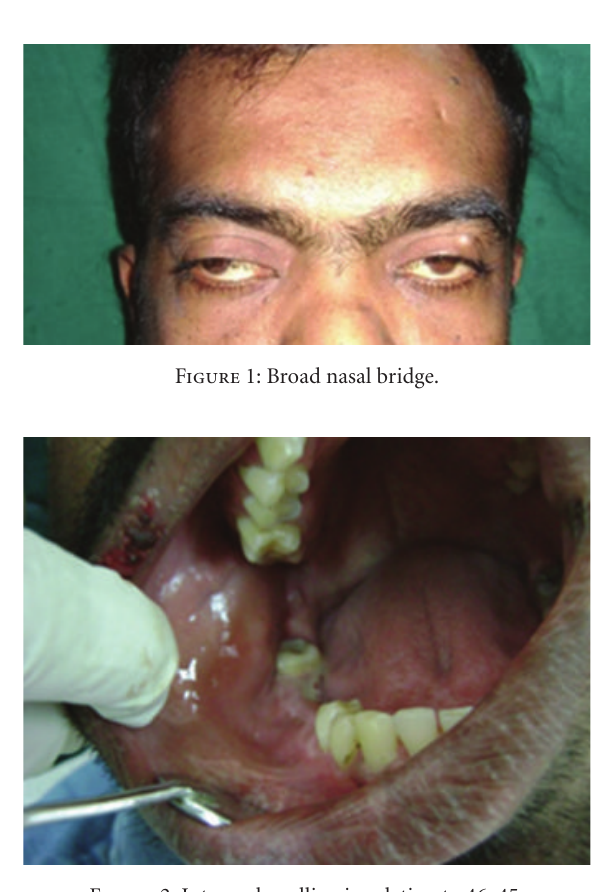
Figure 2: Intraoral swelling in relation to 46, 45.